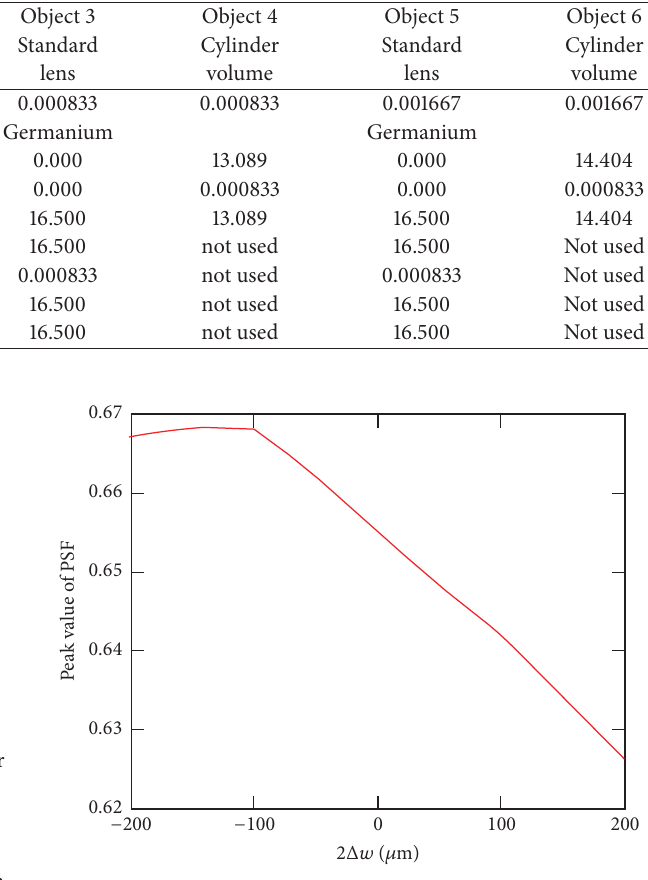
Figure 7: Peak value of PSF as a function of variation in zone width